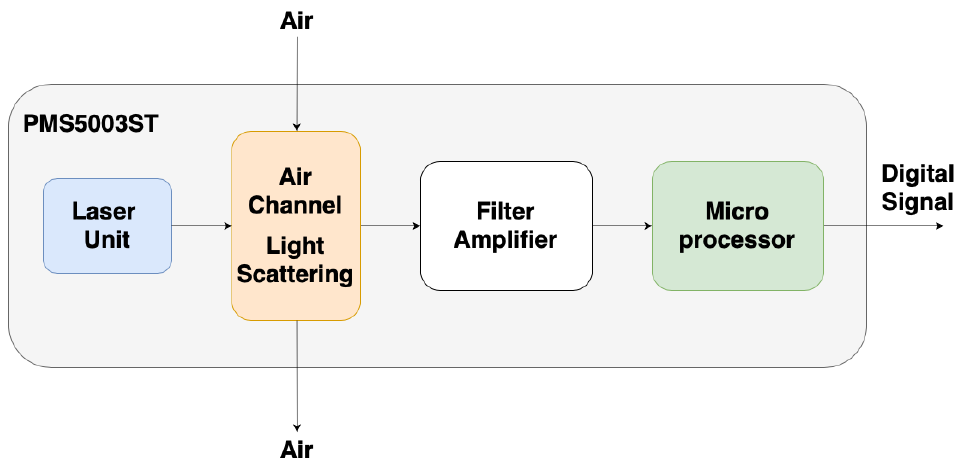
Figure 3. PMS5003ST functional block diagram.